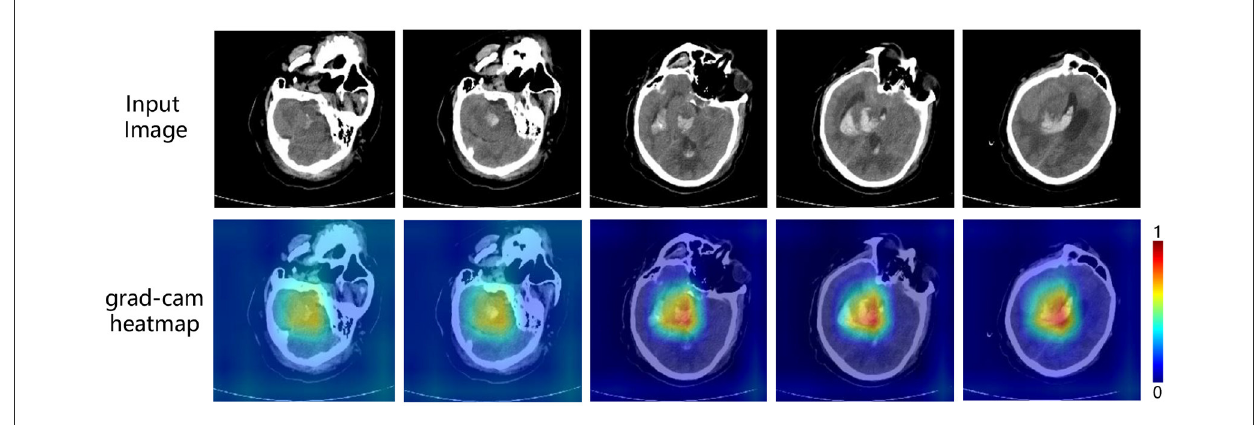
FIGURE5 Interpretable visualization of our multi-task framework. The images are five slices taken from a 3D CT scans at medium intervals ( t = 5).